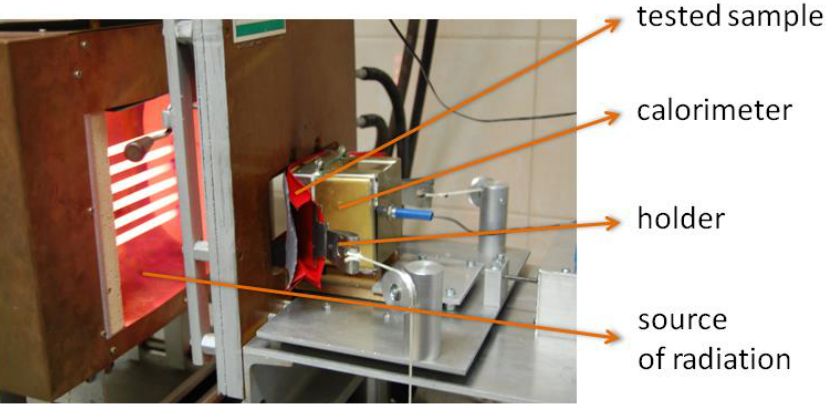
Figure 5. Stand for determining the resistance of materials to radiant heat adapted to the testing of materials with SMA elements.